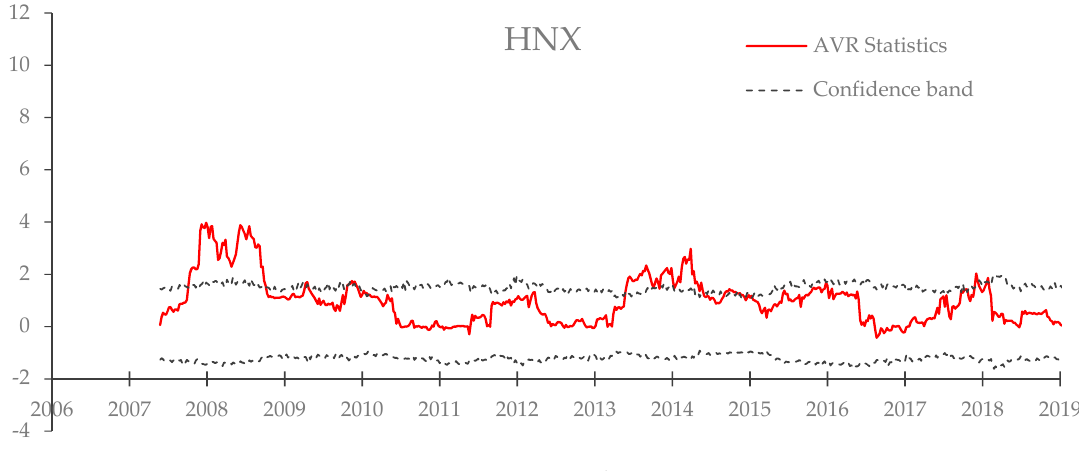
Figure 4. AVR test results in HNX.